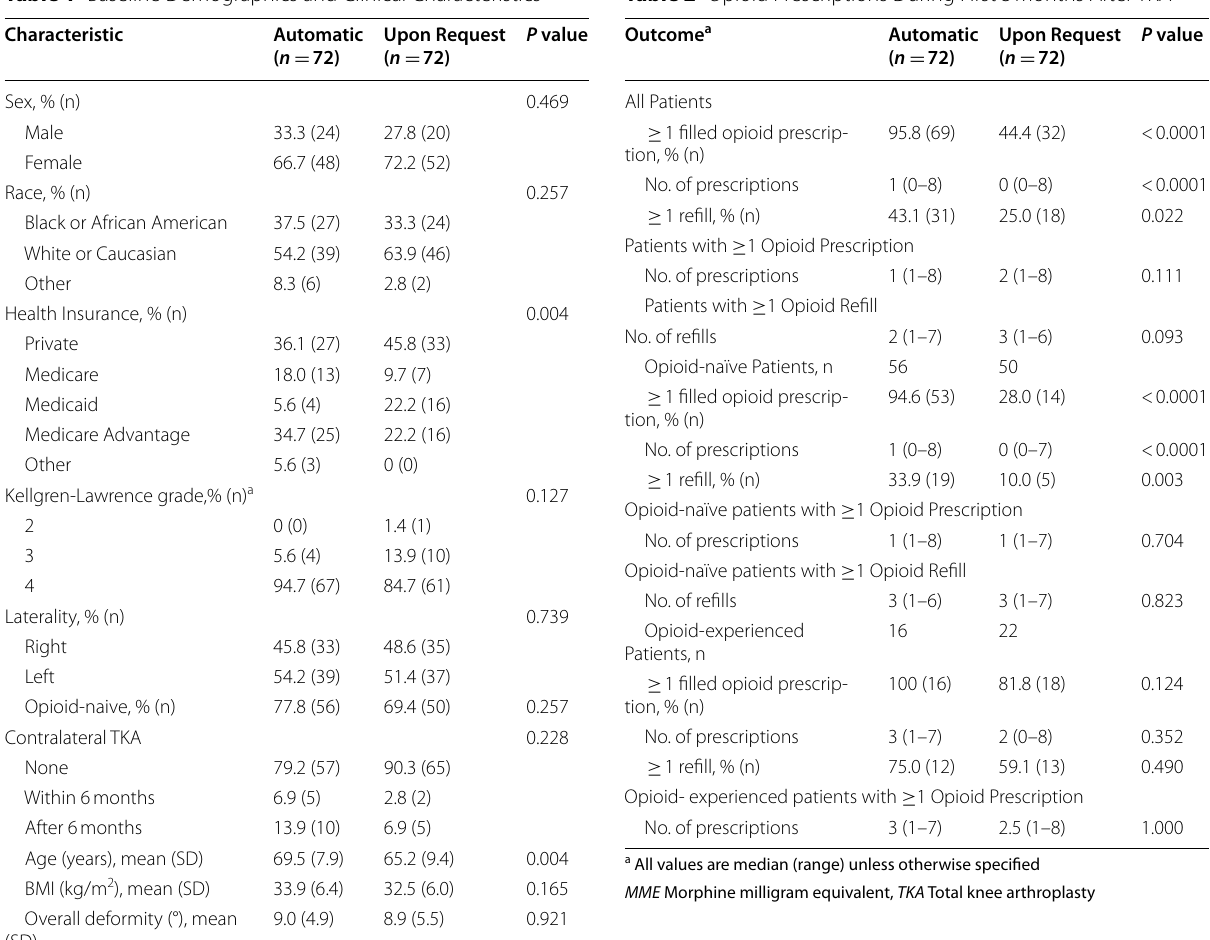
Table 1 Baseline Demographics and Clinical Characteristics Table 2 Opioid Prescriptions During First 3 Months After